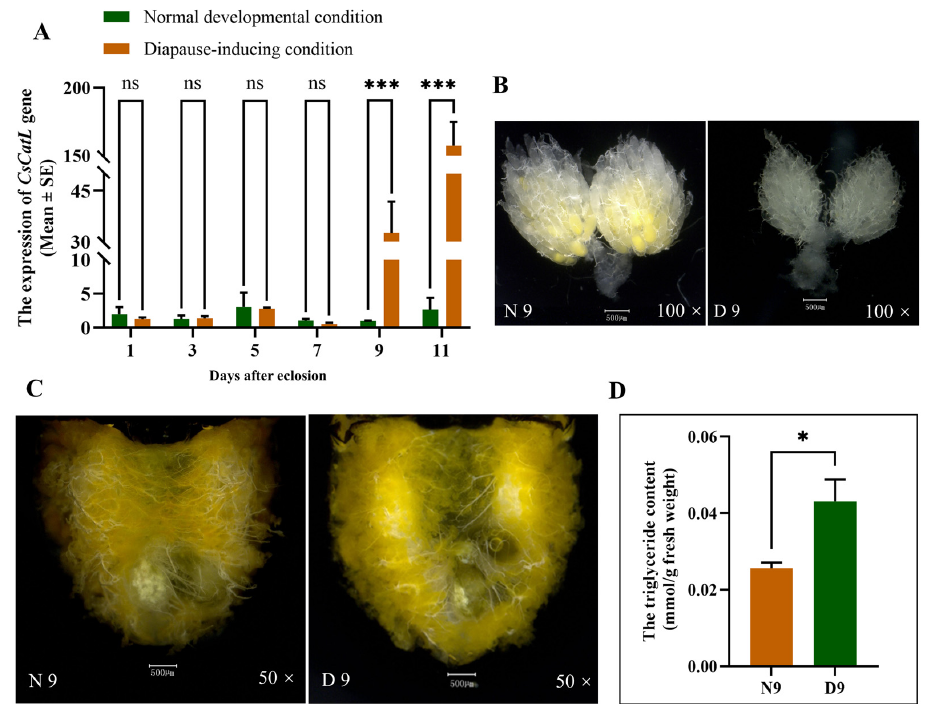
Figure 3. ( A ) Quantitative real-time PCR analysis of CsCatL relative expression during the diapause induction phase (D1, D3, D5, D7, D9, and D11) and during normal development days (N1, N3, N5, N7, N9, and N11). The mRNA expression levels of CsActin and CsCatL were measured at various time points, and data are presented as mean ± SE of triplicate biological replicates. Asterisk and “ns” respectively indicate significant difference (*** p < 0.001) and no significant difference ( p > 0.05) ( t -test); ( B ) ovarian development in N9 and D9; ( C ) lipid accumulation status; ( D ) the total triglycerides contents were measured in N9 and D9, and data are presented as mean ± SE of four biological replicates. Asterisk indicates significant difference ( t -test; * p < 0.05).